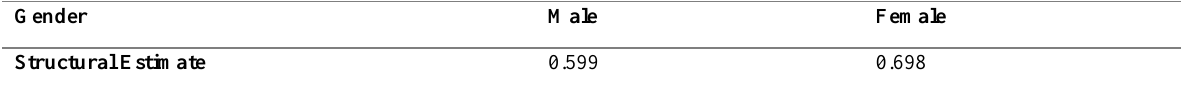
Table 2: Relationship among, number of alternatives and post-purchase regret based on gender Gender Male Female Structural Estimate 0.599 0.698